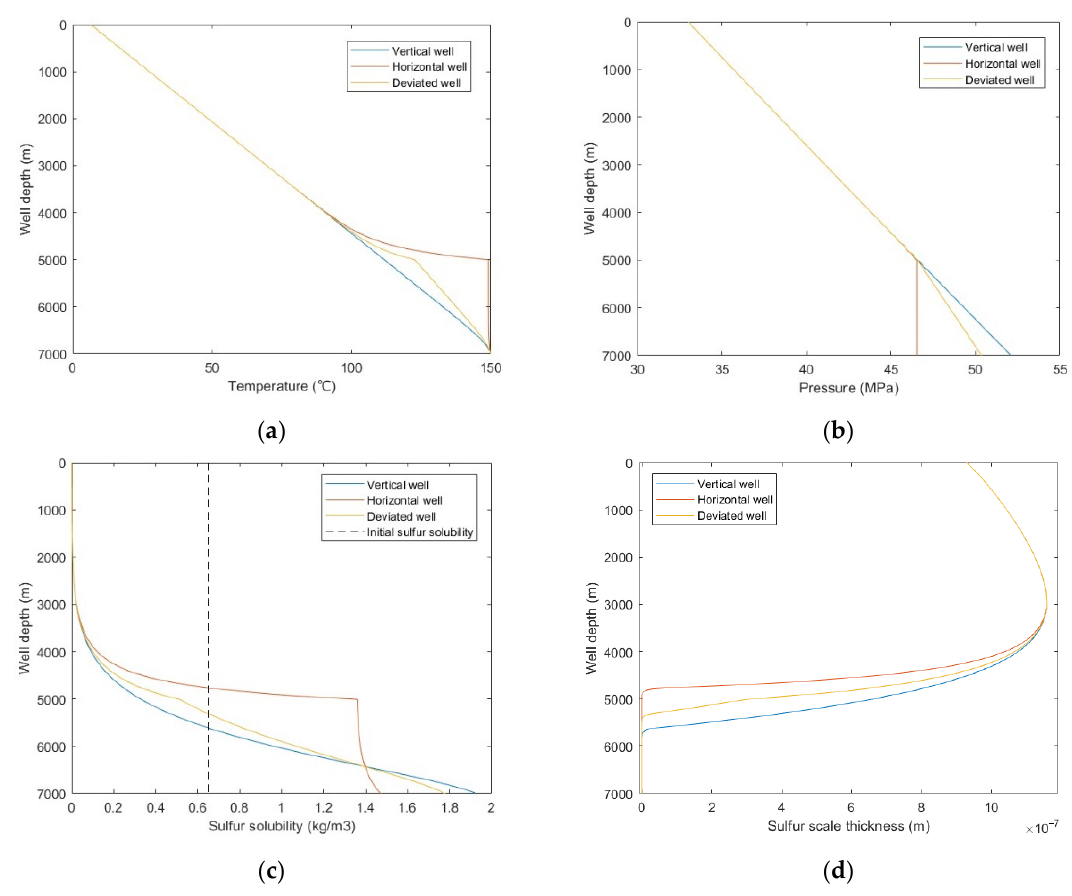
Figure 13. Calculated results with: ( a ) temperature distribution of different well trajectory types; ( b ) pressure distribution of different well trajectory types; ( c ) sulfur solubility distribution of different well trajectory types; ( d ) sulfur scale thickness distribution of different well trajectory types.